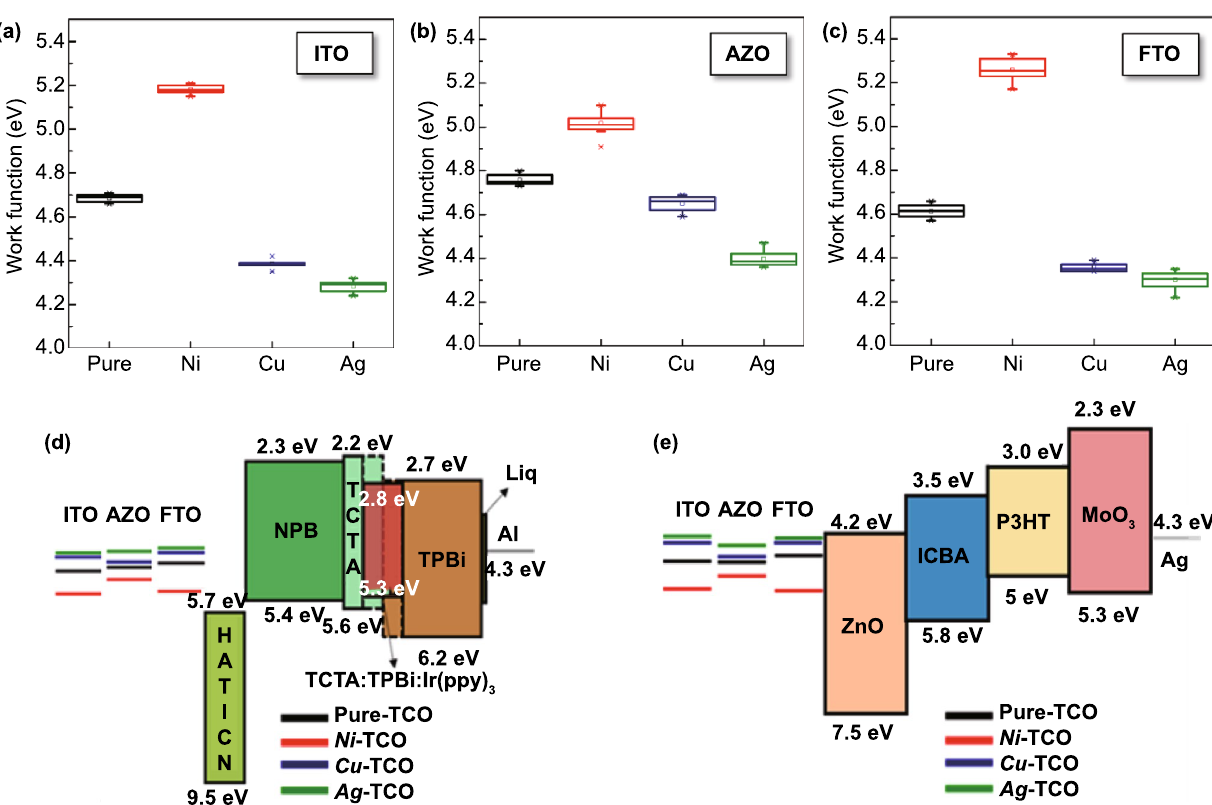
Fig. 3 Work function of m ‑TCOs: a m ‑ITO, b m ‑AZO, and c m ‑FTO. Schematic energy band diagram of the components that comprise the d OLED and e OPV with the various EMi applied electrodes (Ref. TCO and m